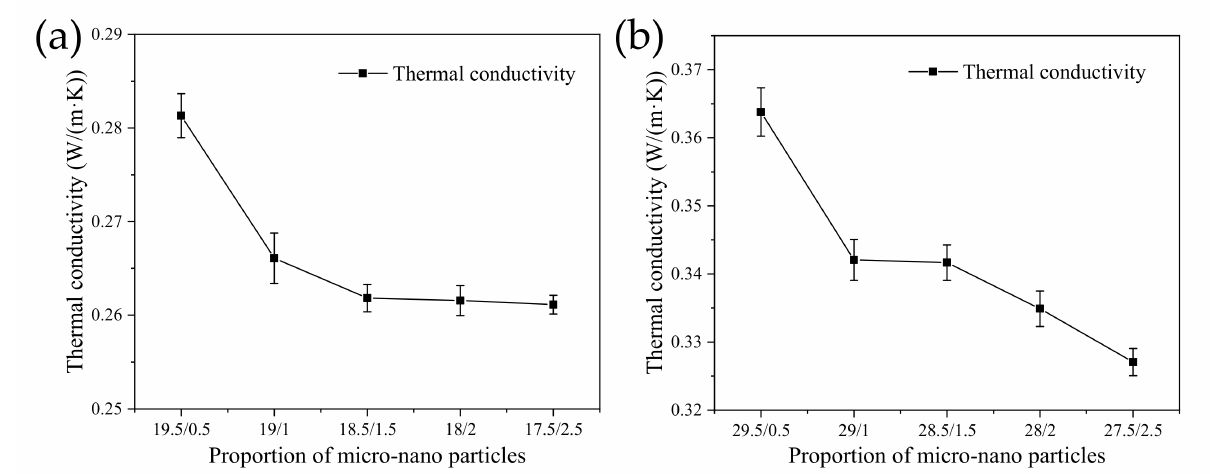
Figure 21. Thermal conductivity of micro-nano compound SiC/EP composite. ( a ) 20 wt% SiC/EP; ( b ) 30 wt%